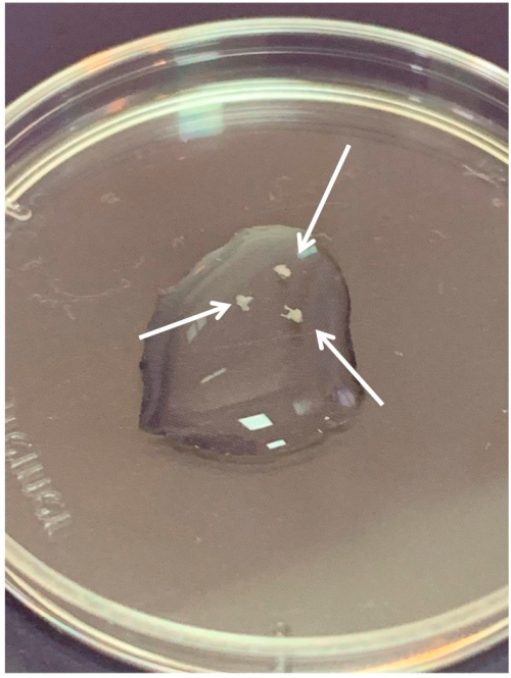
Figure 2. Three dorsal root ganglia (DRGs) in HBSS. Arrows point to the DRGs.